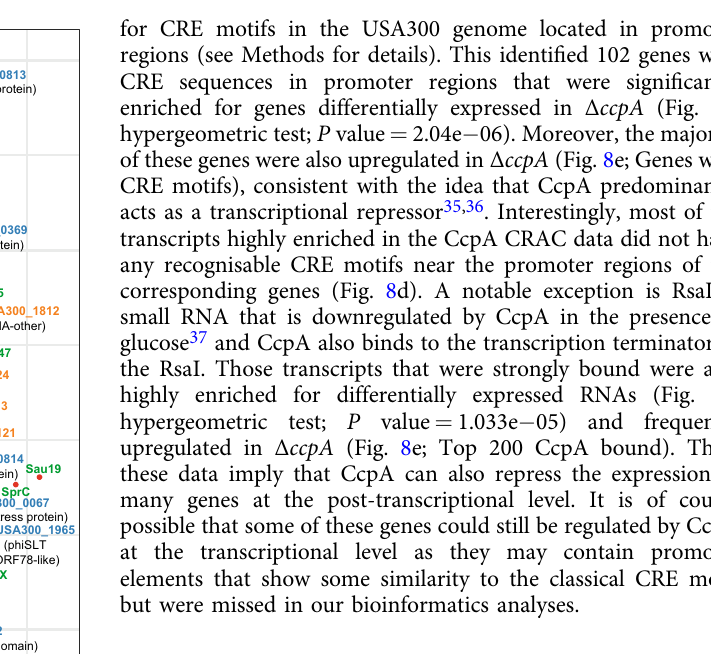
Fig. 3 PTex and 2C reliably detect RNA-binding proteins in S. aureus . a Overlap between PTex and 2C RBPome data sets generated from cells grown in LPM medium. b – g UV cross-linking analysis of known ( b ) and predicted RBPs ( c – g ). USA300 strains expressing HTF-tagged fusion proteins were irradiated with different UV intensities. HTF-tagged proteins and cross-linked RNA were puri fi ed under highly stringent and denaturing conditions (see ‘ Methods ’ for details). After a mild RNase digestion and 5 ’ 32 P labelling of the cross-linked RNA, samples were resolved by NuPAGE, transferred to nitrocellulose and cross-linked ribonucleoprotein complexes were detected by autoradiography (upper panel). Western blot analysis with anti-TAP antibodies was performed to visualise the (free) proteins (lower panel). Asterisks indicate signals that were generated from overnight exposures of gels for autoradiograph. Other exposures were 3 h or less. h CcpA UV preferentially cross-links to RNA. Cells expressing CcpA-HTF were UV-irradiated and cross- linked CcpA-nucleic acid complexes were incubated with an increasing amount of RNase A/T1 (lanes 1 – 3) or RQ1 DNase (lanes 4 – 6). The original pictures from one replicate of the CRAC experiments shown in b – h are provided as a Source data fi le.